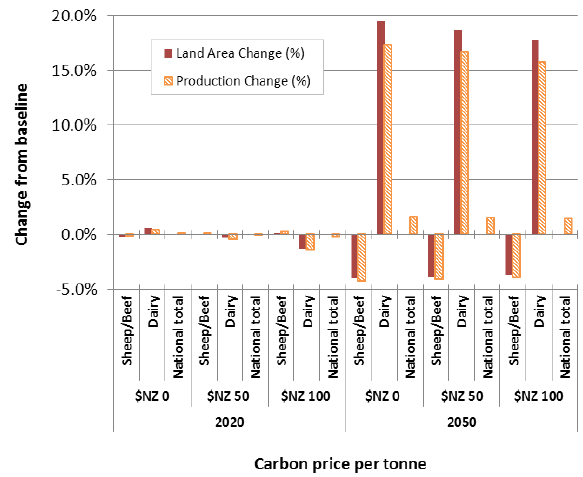
Figure 6. Land area and pasture production changes. Percentage change from baseline estimated by combining outputs of LURNZ and Biome-BGC models in 2020 and